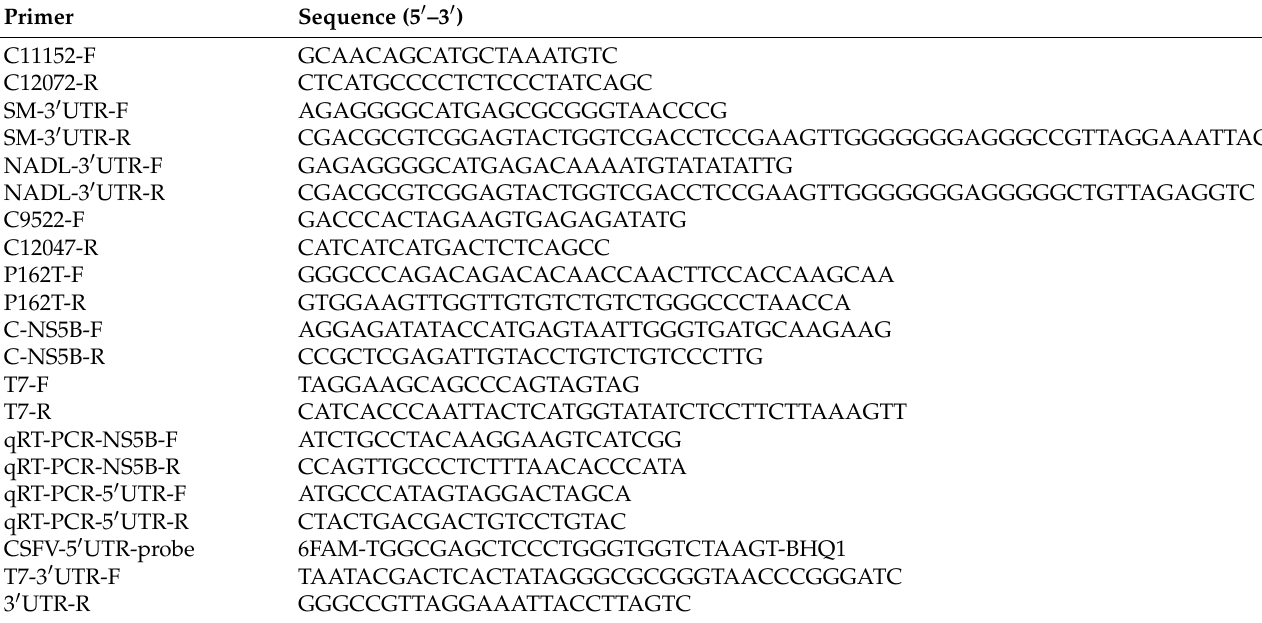
Table 1. Primers used in this